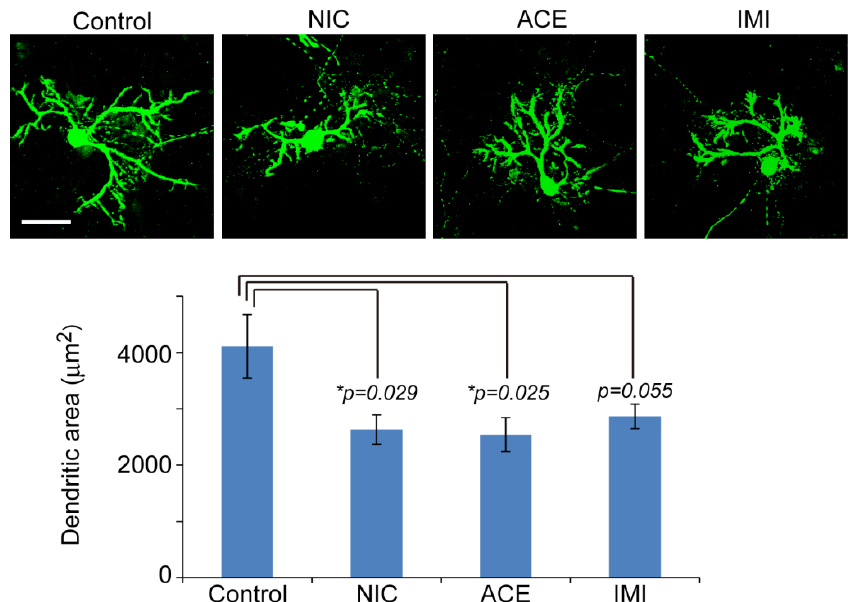
Figure 2. Dendritic arborization of Purkinje cells in cerebellar cultures exposed to nicotine (NIC), acetamiprid (ACE), and imidacloprid (IMI) for 14 days (16DIV). A slight disturbance in the dendritic arborization exposed to NIC, ACE, and IMI was observed. Upper panel shows a representative cell from each group stained for anti-calbindin D28k. Bar = 50 μm. Graph shows MetaMorph quantification of calbindin D28k-reactive dendritic area (without cell soma) ( n = 10 cells per group). Error bar represent standard errors. T -tests were conducted for each treatment versus control. * p < 0.05.